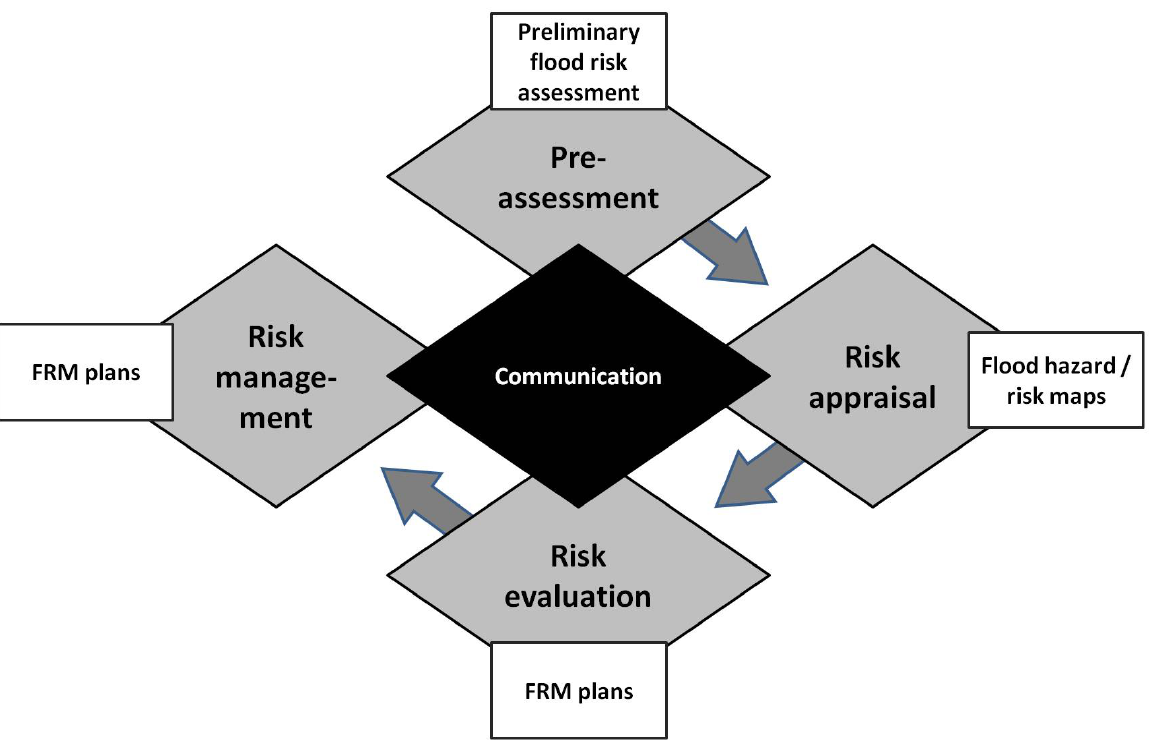
Figure 2. Comparing the risk governance concept [25] to the floods